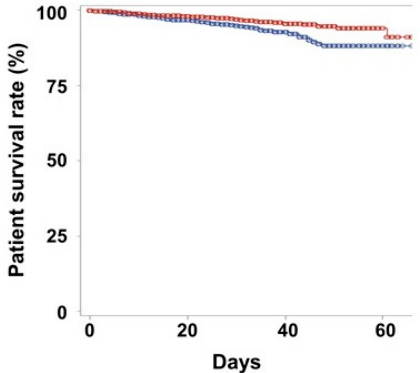
Figure 1. Kaplan–Meier survival curves, according to sex. The blue line shows the survival graph for men, and the red line shows the graph for women. The circle reveals the censored point. The 20-day survival rates for men and women were 96.6% and 97.9%, respectively ( p < 0.001). The 40-day survival rates for men and women were 92.8% and 95.5%, respectively. The number of patients with hospitalization was 2800 (94.5%) in men and 4111 (94.2%) in women, respectively ( p = 0.681). There were 17 (0.6%) men and 10 (0.2%) women who developed AKI ( p = 0.017; Table 3). The rate of use of inotropes, conventional oxygen therapy, HFNC, MV, cardiac arrest, and MI were greater in men than in women. Multivariate logistic regression analyses showed that the odds ratios for the use of inotropes, conventional oxygen therapy, HFNC, MV, AKI, cardiac arrest, and MI were greater for men than for women (Table 4). The odds ratios for ECMO and AHF were greater for men than for women, but no statistical significance was observed. Among patients without prevalent cerebrovascular disease, 15 (0.5%) men and 5 (0.1%) women had newly developed cerebrovascular disease ( p = 0.002). Regarding incident pulmonary embolism, 13 (0.4%) men and 13 (0.3%) women had this condition ( p = 0.325). A total of 18 (0.6%) men and 10 (0.2%) women had disseminated intravascular coagulation ( p = 0.012). Table 2. Cox regression analysis of mortality according to the variables.